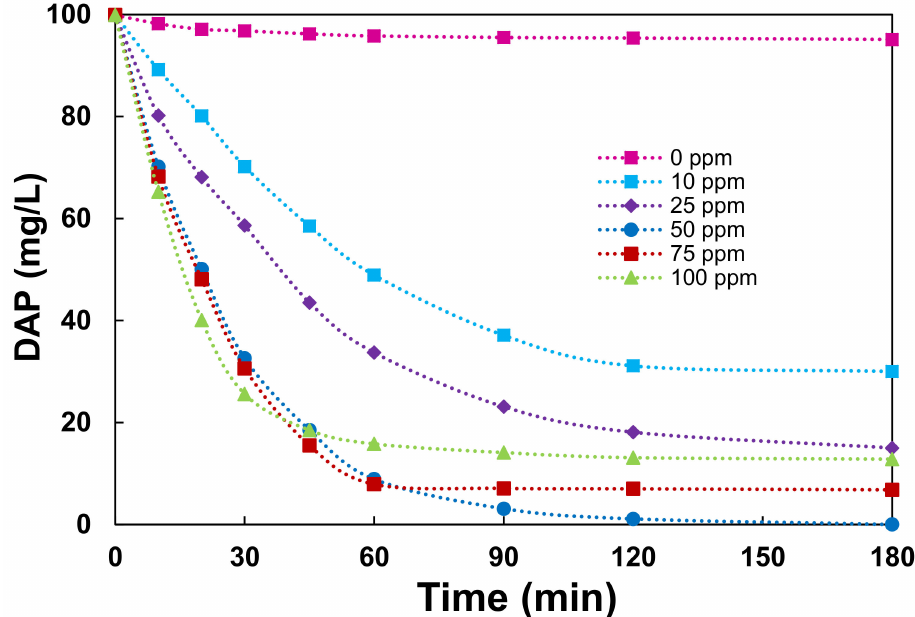
Figure 3. Effect of Fe 2+ content on the DAP degradation kinetics during the Fenton process (H 2 O 2 /Fe 2+ ). Experimental conditions: [DAP] 0 = 100 mg/L; [H 2 O 2 ] = 1000 mg/L; [Fe 2+ ] = 0–100 mg/L; pH =